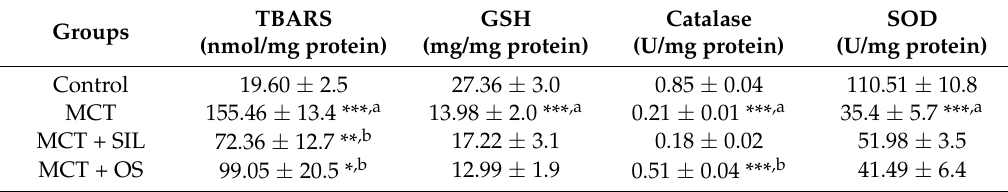
Table 2. Effect of OS on lung thiobarbituric acid reactive substances (TBARS) levels, lung reduced GSH, lung catalase, and lung superoxide dismutase (SOD) levels in MCT-induced PH. Values are expressed